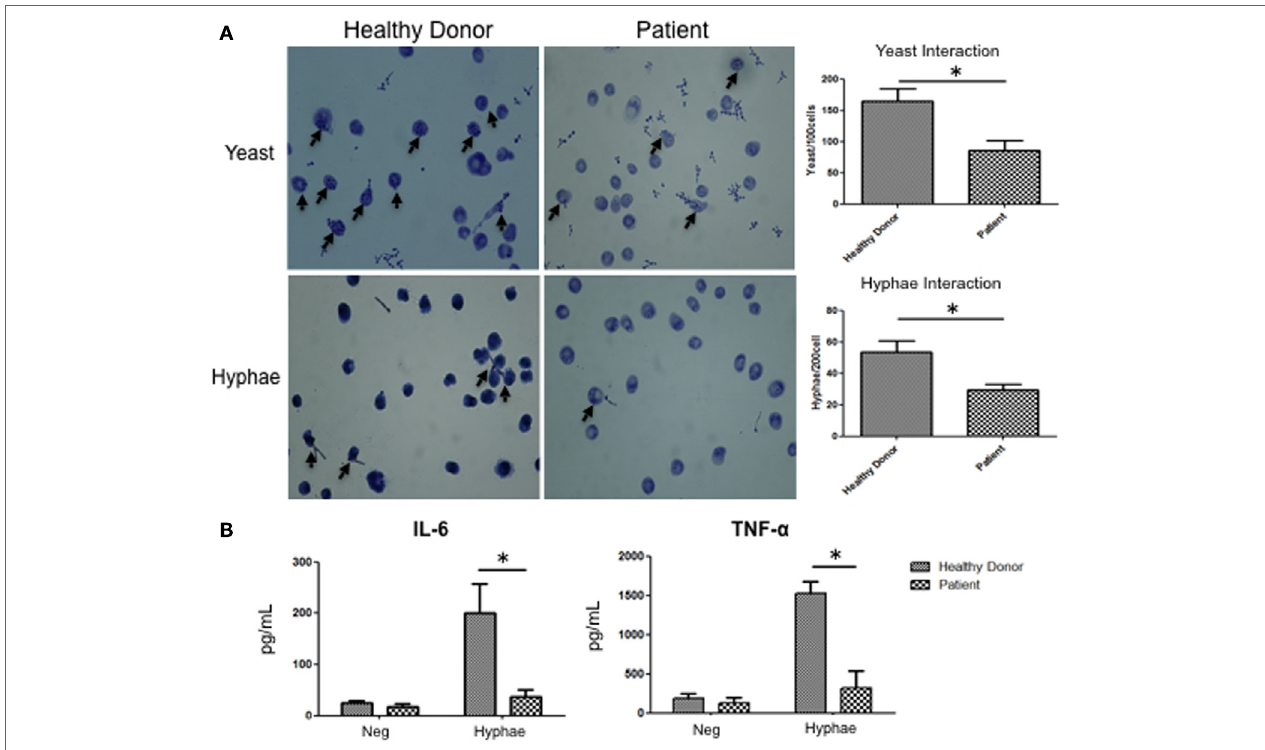
FigUre 7 | Fungal response in macrophages from autoimmune-polyendocrinopathy-candidiasis-ectodermal dystrophy (APECED) patients. (a) Representative images of C andida albicans phagocytosis in macrophages from healthy donors and AIRE-deficient patients after 30 min of stimulation with yeast or hyphae. The arrow indicates fungal phagocytosis by macrophages. The images on the right show the numbers of yeast and hyphae inside of the macrophages. (B) IL-6 and TNF- α secretion by macrophages from a healthy donor or AIRE-deficient patient in cells unstimulated or stimulated with hyphae for 24 h. (a,B) The horizontal bars denote the mean. * p < 0.05 as determined by the t -test. Representative image of four independent experiments for both healthy donors and APECED